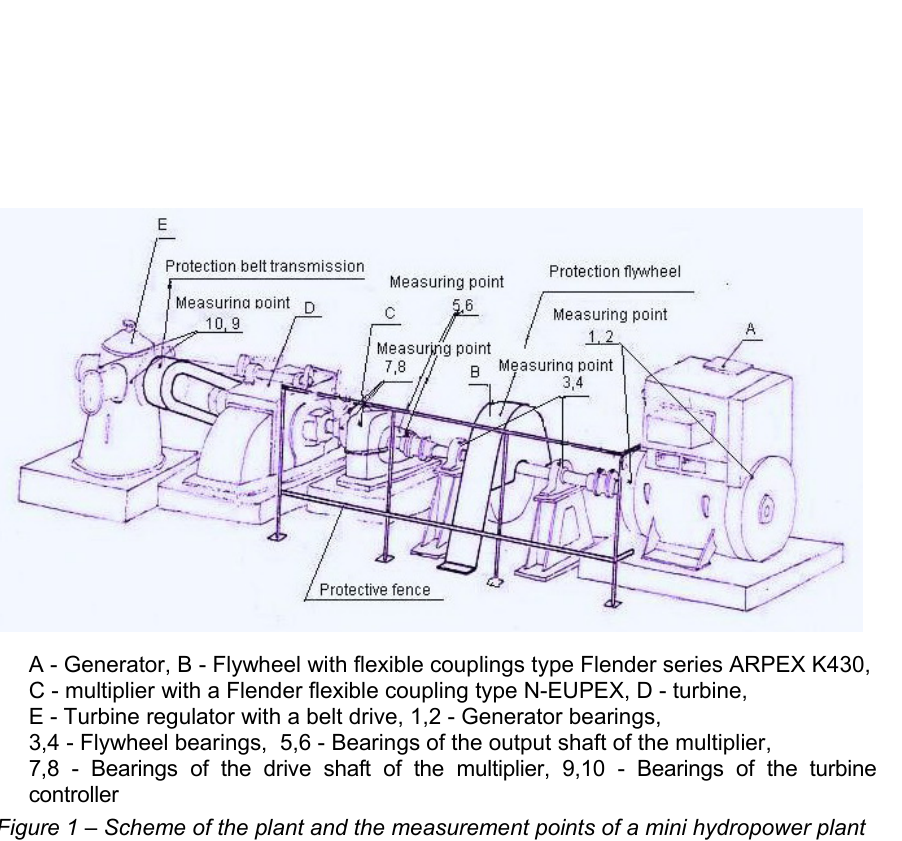
Figure 1 – Scheme of the plant and the measurement points of a mini hydropower plant Рисунок 1 – Схема установки и точек измерения на установках мини - ГЭС Слика 1 – Шема постројења и мерних места на постројењу мини -